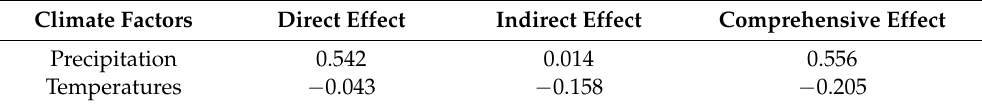
Figure 5. Spatial distribution of effects of precipitation and air temperature on vegetation NDVI. Table 3. Influence of multi-year mean climate on vegetation NDVI.